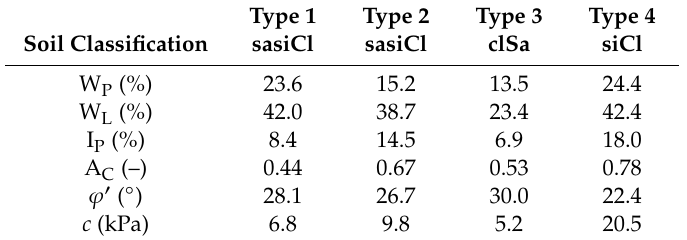
Table 1. Physical properties of four types of cohesive material tests in this